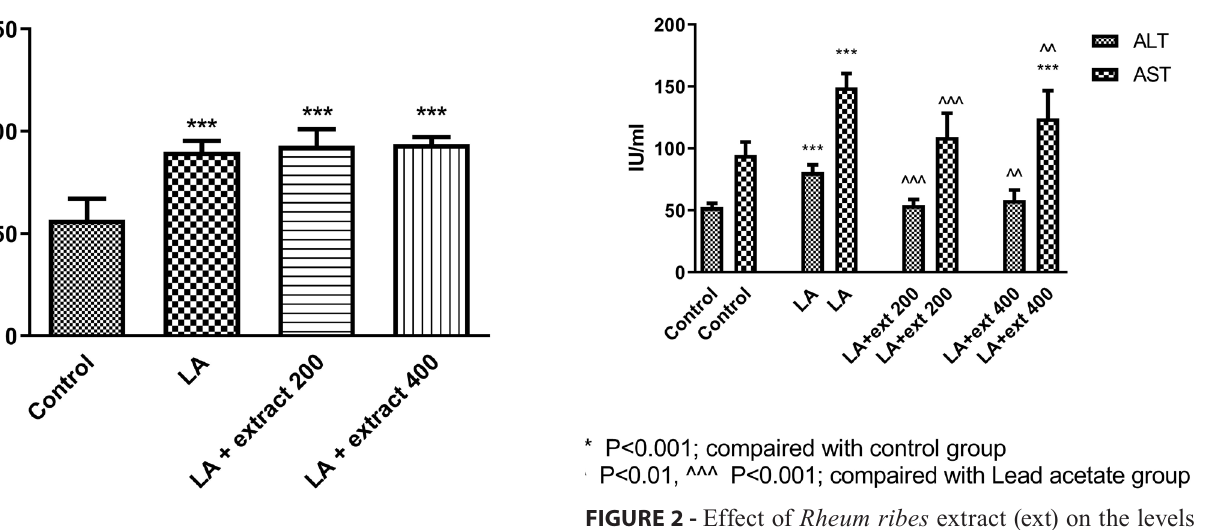
FIGURE 2 - Effect of Rheum ribes extract (ext) on the levels of alanine aminotransferase and aspartate aminotransferase in rats treated with lead acetate (LA).